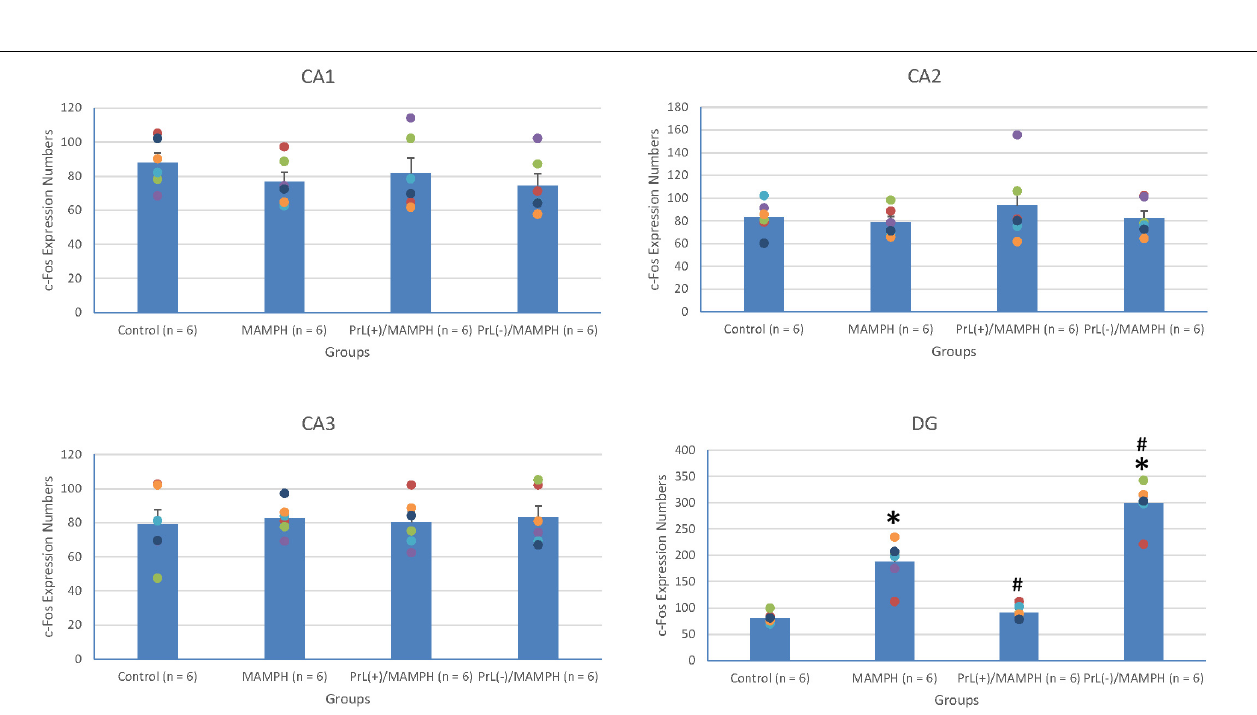
FIGURE 9 | MAMPH administrations were tested in order to label c-Fos expression in the CA1, CA2, CA3, and DG of the hippocampus for the control ( n = 6), MAMPH ( n = 6), PrL(+)/MAMPH ( n = 6), and PrL(–)/MAMPH groups ( n = 6) by injecting NMDA or saline into the PrL. PrL(+): injection of a low concentration of NMDA to excite the PrL neurons; PrL(–): Injection of a high concentration of NMDA to destroy the PrL neurons. Differences in c-Fos expression levels in the CA1, CA2, CA3, and DG among all groups were analyzed by one-way ANOVA, followed by Tukey’s post hoc test if a significant difference was appeared among groups. ∗ p < 0.05 indicates significant differences compared with the control group; # p < 0.05 indicates significant differences compared with the MAMPH group.